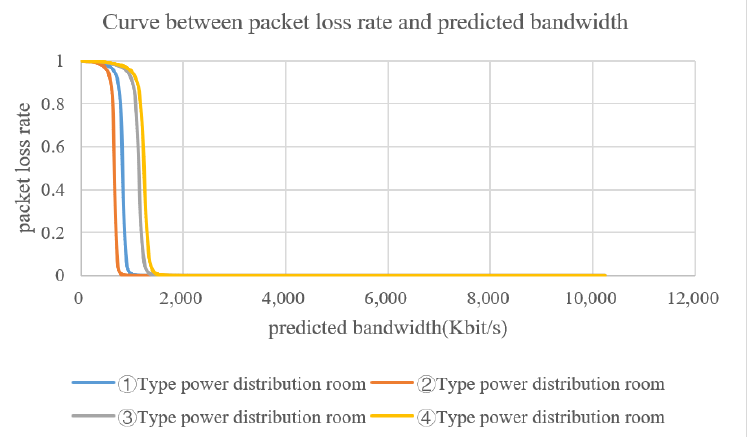
Figure 8. Curve between packet loss rate and predicted bandwidth.